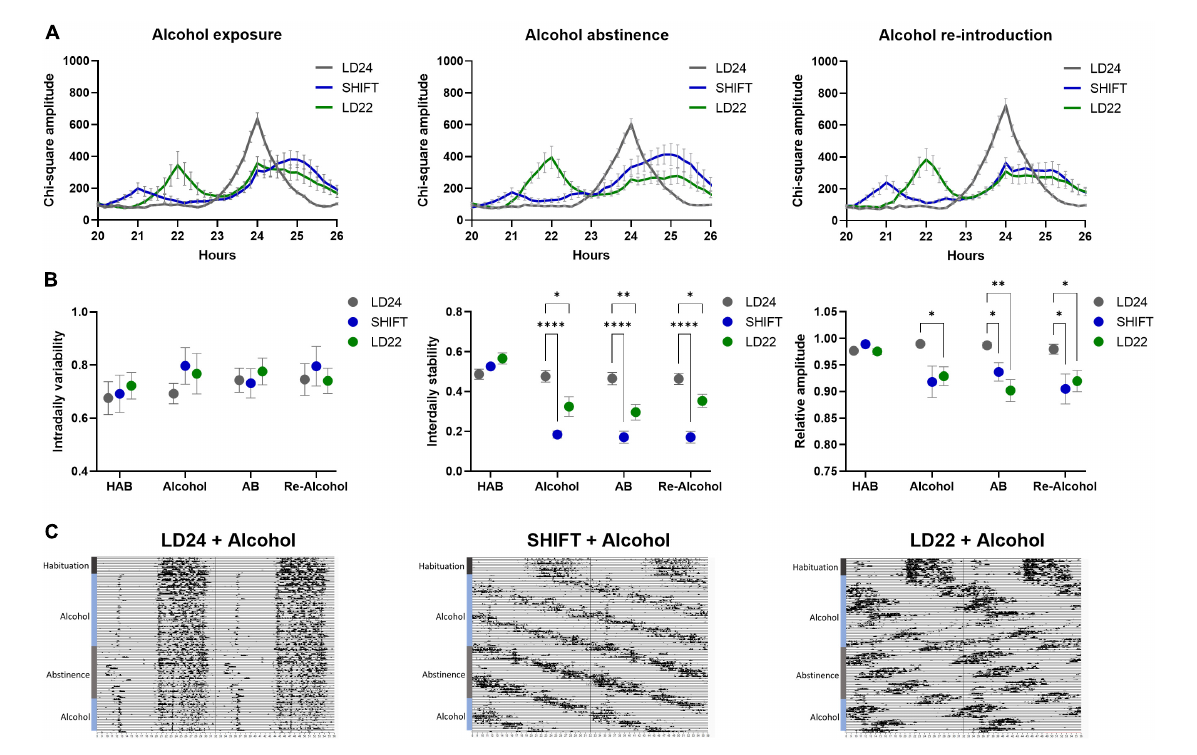
FIGURE3 Locomotor activity under altered light-dark (LD) conditions and intermittent alcohol exposure. (A) Comparison of periodograms and actograms during access to alcohol, alcohol abstinence, and re-introduction of alcohol. (B) Intradaily variability (IV), interdaily stability (IS), and relative amplitude (RA) during habituation (HAB), intermittent access to 20% alcohol solution (Alcohol), abstinence (AB), and reintroduction of alcohol after abstinence (Re–Alcohol). Two-way ANOVA, Dunnett’s multiple comparisons test: ∗∗∗∗ p < 0.0001, ∗∗ p < 0.01, ∗ p < 0.05; ± SEM; n = 4–12/LD condition. (C) Representative circadian actograms for one animal for each LD paradigm and alcohol exposure. Time of day is double-plotted along the x-axis, and successive days are arranged from top to bottom along the y-axis and labeled with the coinciding alcohol exposure phase.